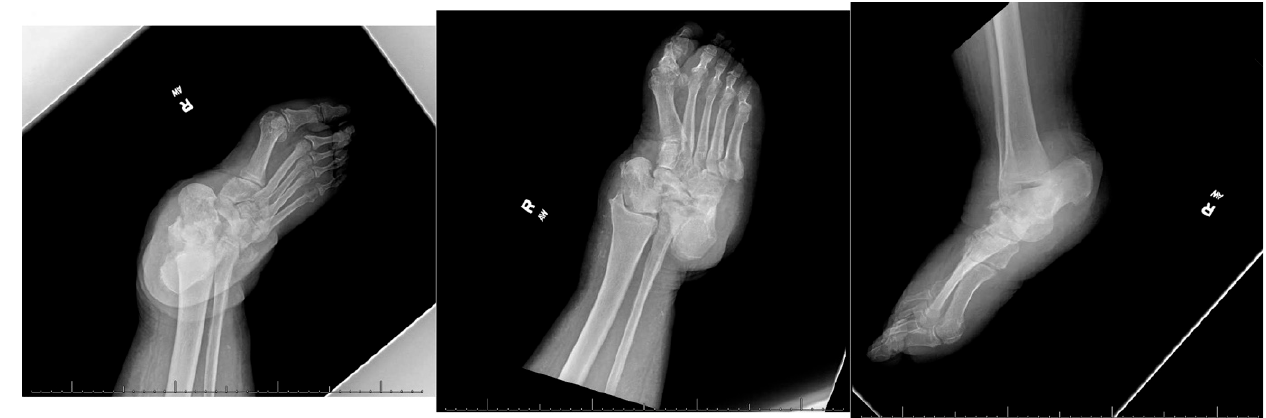
Figure 1. Preoperative radiographic images.